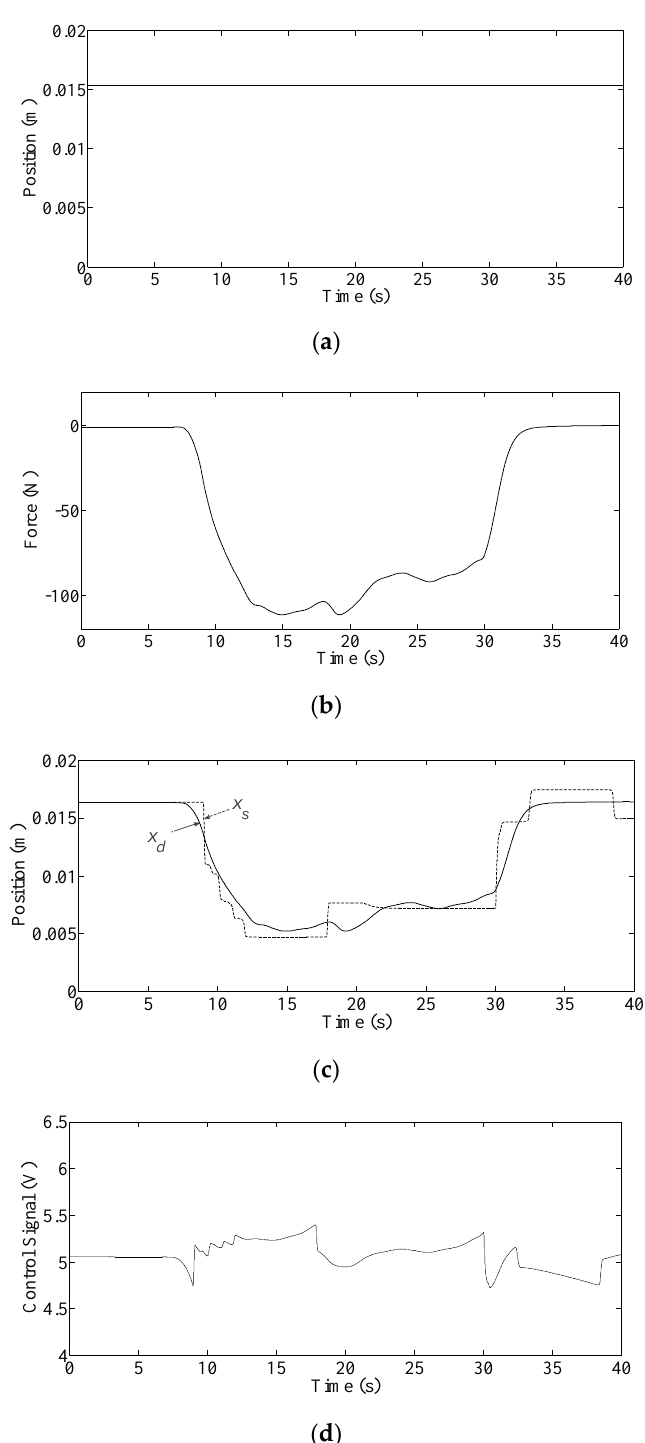
Figure 7. Experimental study of high stiffness admittance model while tracking a human-guided trajectory: ( a ) primary desired position by the master manipulator, x m ; ( b ) external force, F ext ; ( c ) modified desired trajectory, x d , versus position of actuator, x s ; ( d ) control signal, u